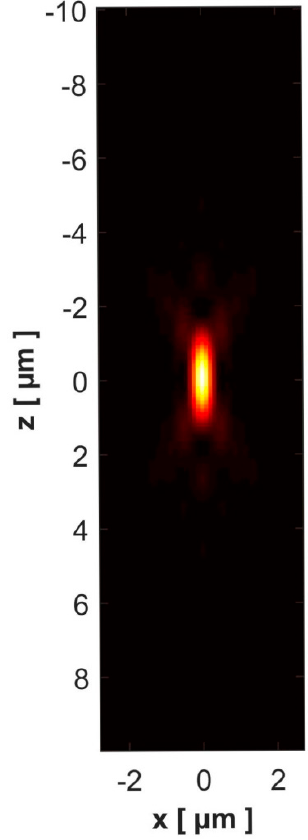
Figure 2. X–Z cross section of the computed point spread function (PSF) with the acquisition parameters of the experimental device: the numeric aperture of the dry objective NA ob = 0.75 with working WD = 0.71 mm; the refractive index of specimen layer n m = 1.33; the standard value of refractive index of the air n c ∗ = 1; the refractive index of the air during the experimentation n c = 1.00024, z p = 0; the pixel size in the object space is 0.1 µ m.